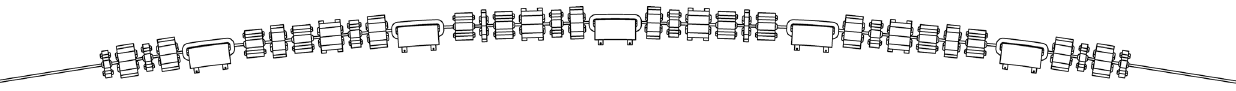
FIG. 1. Top view of one super period of the ILSF storage ring lattice [24].